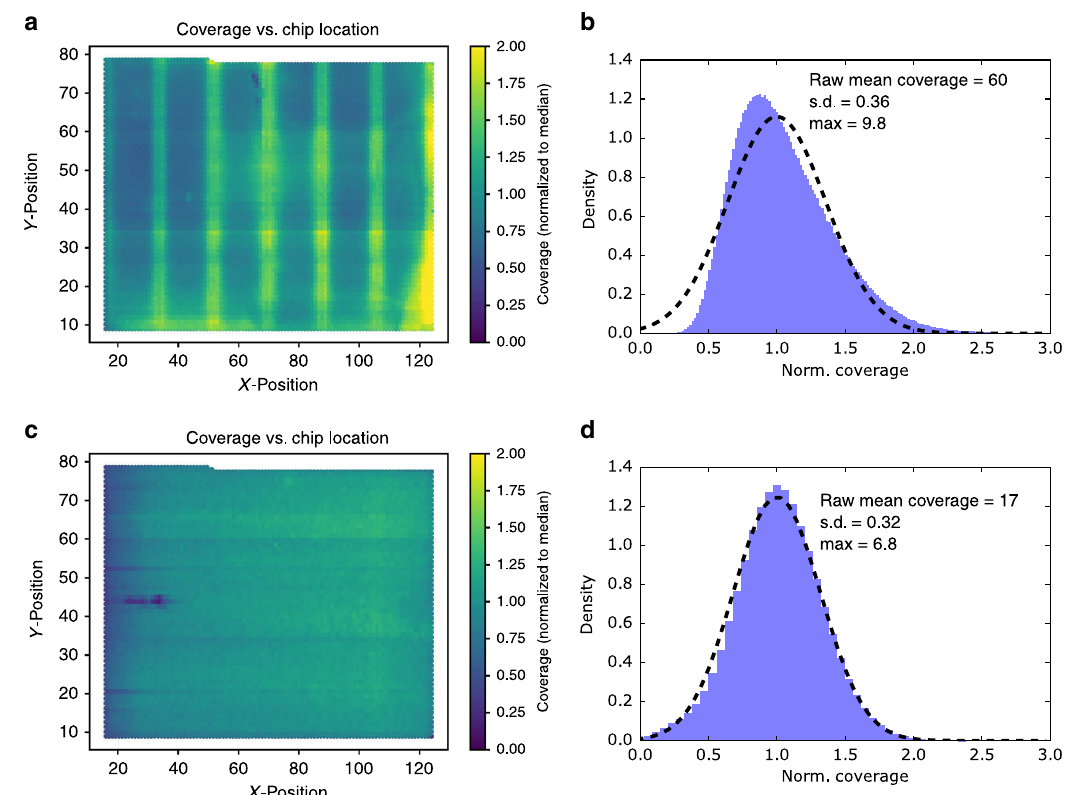
Fig. 3 Oligo copy distribution on the synthesis chip. a The sequencing coverage of each oligo from the fi rst ready-to-sequence pool was mapped back to its corresponding location on the synthesis chip. Coverages are normalized to the median. b The histogram of normalized sequencing coverage of the fi rst ready-to-sequence pool (blue). The distribution does not fi t a normal distribution (dashed line). c The sequencing coverage of each oligo from the second ready-to-sequence pool, mapped back to its corresponding location on the synthesis chip. Coverages are normalized to the median. d The histogram of normalized sequencing coverage of the second ready-to-sequence pool (blue). The second ready-to-sequence pool showed much more even oligo copy distribution and fi ts a normal distribution (dashed line) much more closely than then fi rst. The unique number of sequences (sample size) is 1,536,168. Source data are available in the Source Data fi